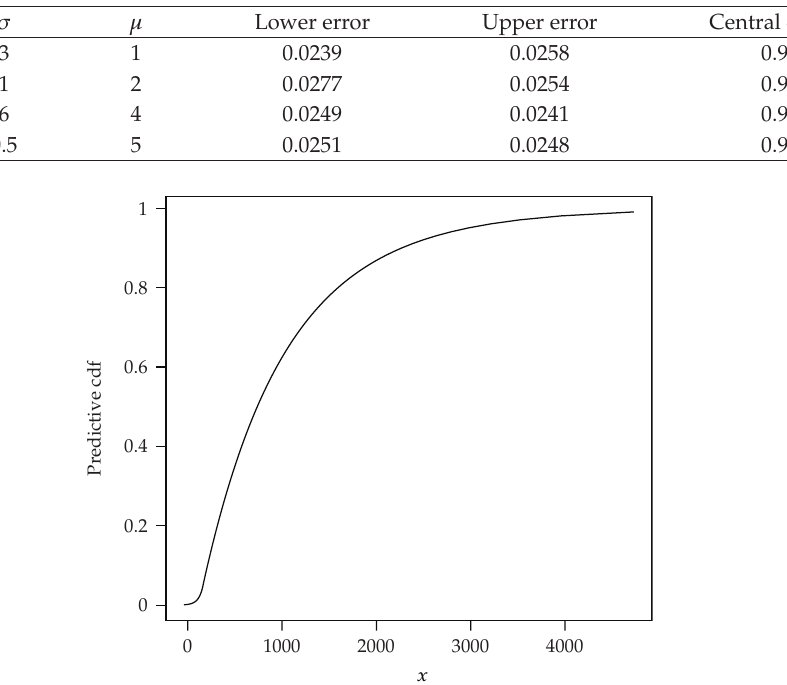
Figure 2: The predictive cumulative distribution function, F P (cid:2) x (cid:3)